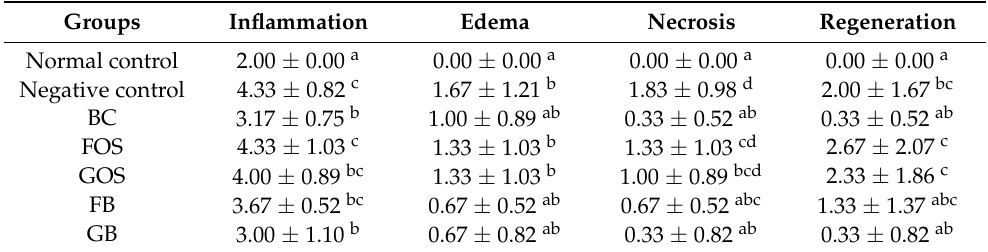
Table S2. (A–C) The concentrations of acetic acid ( μ mol/g) in fecal samples collected at different time points; Table S3: Primers used for 16S rRNA gene analysis.